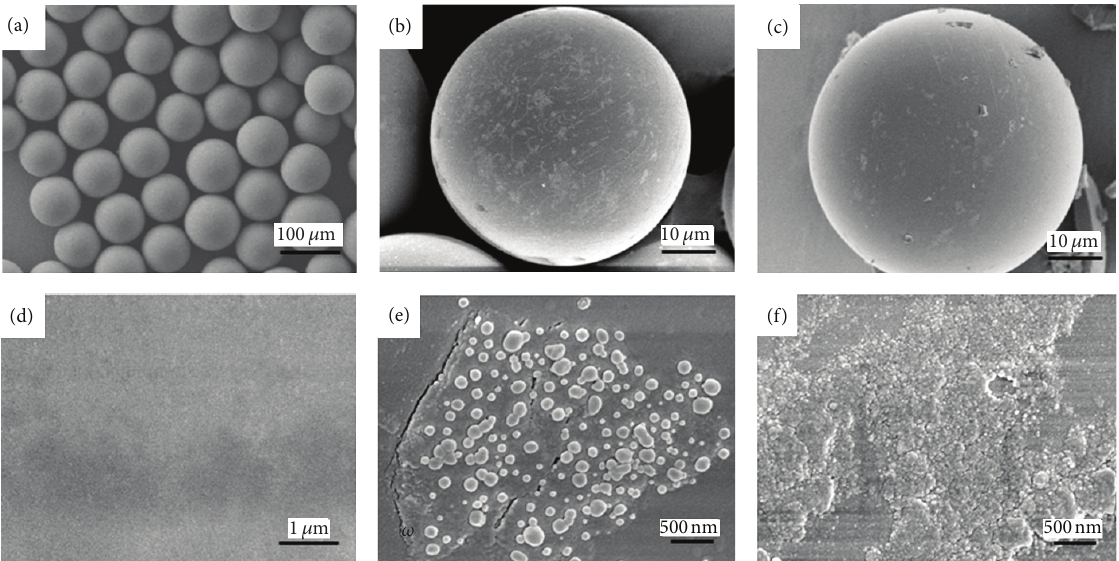
F 3: SEM images of chloromethylated bead (a and d), fresh PS-QPS (b and e), and used PS-QPS (c and f). 07580859095100